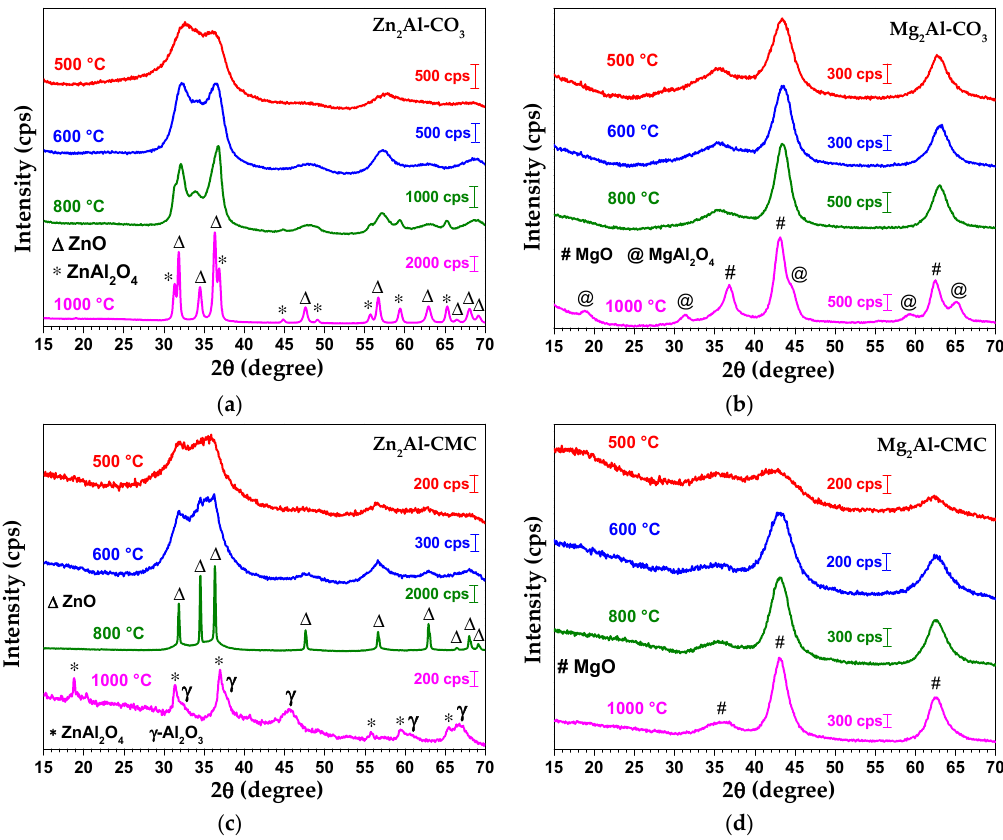
Figure 8. XRD patterns of Zn 2 Al-CO 3 ( a ), Mg 2 Al-CO 3 ( b ), Zn 2 Al-CMC ( c ) and Mg 2 Al-CMC ( d ) samples pyrolyzed at 500, 600, 800 and 1000 °C under N 2 atmosphere. The phases were indicated according to ZnO (wurtzita; ICSD 26170), ZnAl 2 O 4 (ICSD 75091), MgO (periclase; ICSD 9863), MgAl 2 O 4 (ICSD 31373) and γ -Al 2 O 3 (ICSD